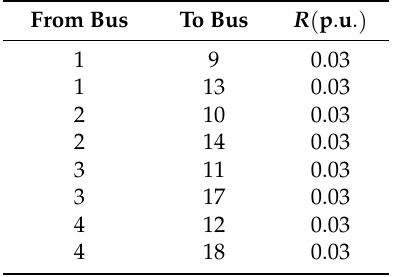
Table A2. DC line data of test system.